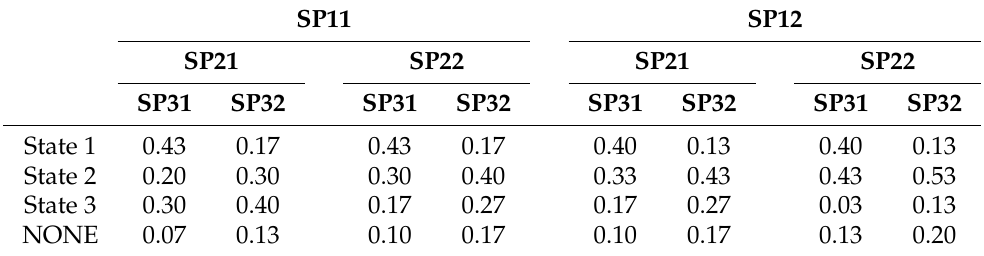
Table 5. Example of the final CPT for the second